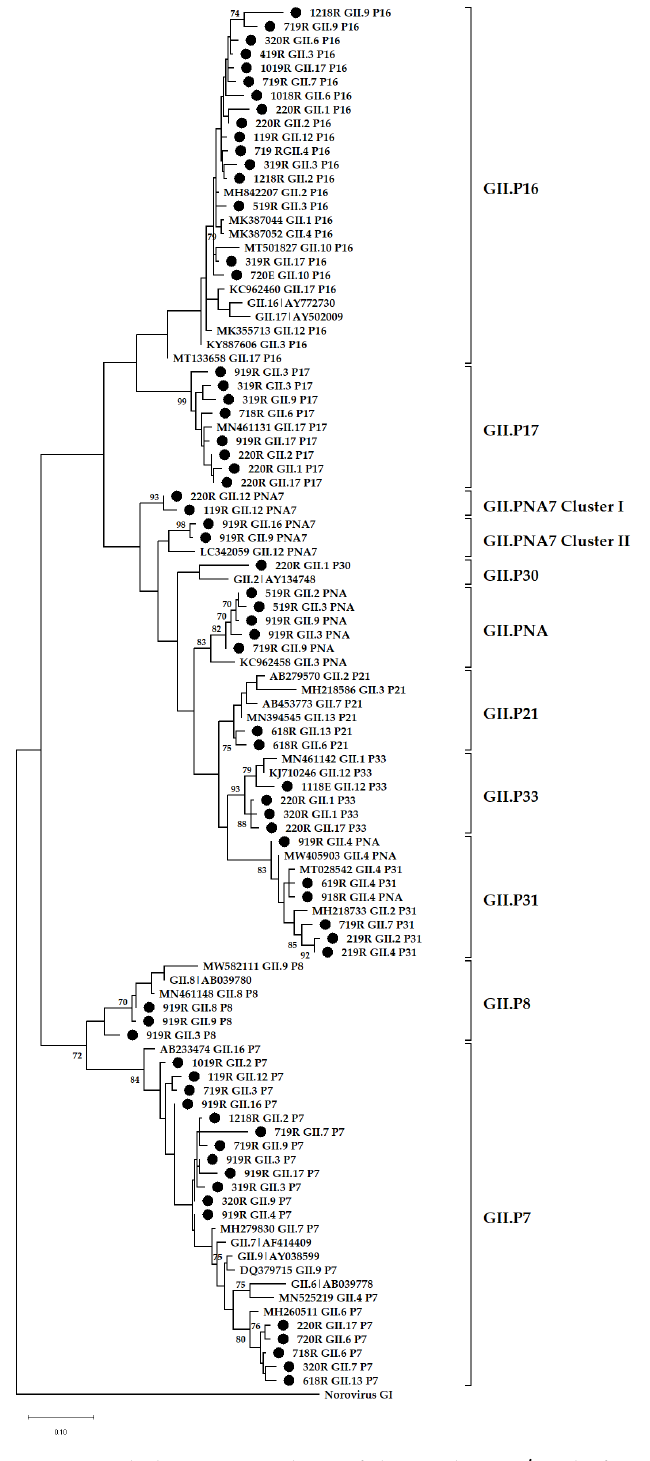
Figure 6. Phylogenetic analysis of the 265 bp at 3 (cid:48) -end of norovirus GII ORF1. Representative sequences identified in this study are indicated by black circles ( • ). All strain sequence names contain specific ID, genotype and P-type. Reference strains and the most closely related strains were downloaded from GenBank. The Maximum Likelihood phylogenetic trees were constructed using MEGA X software [46] and 1000 bootstrap replicates based on the Kimura 2-parameter model. The sequences were labelled according to month and year of detection, wastewater type, P-type and genotype, e.g., 618RGII.2[P2] = GII.2[P2] virus detected in raw sewage collected in June